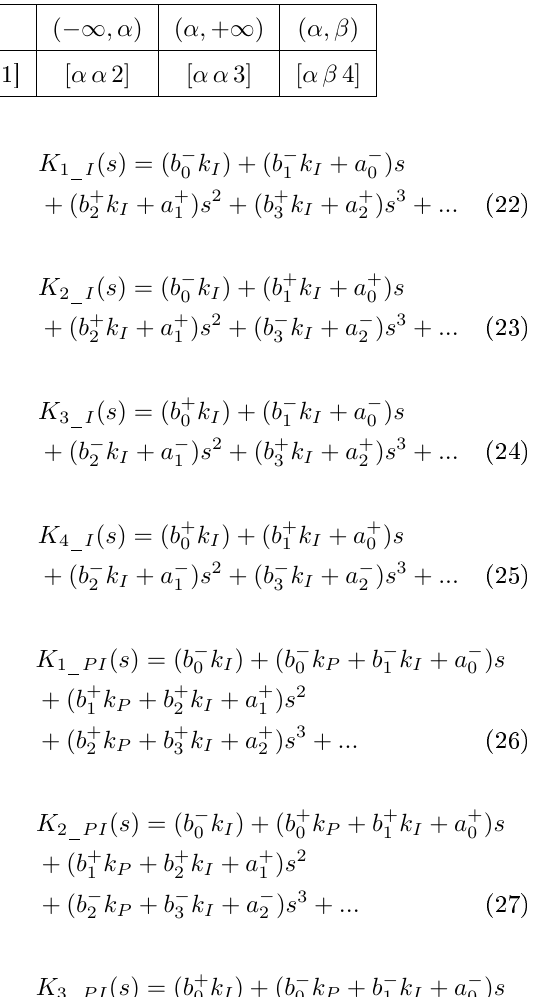
Table 1. Description of used sets on Matlab